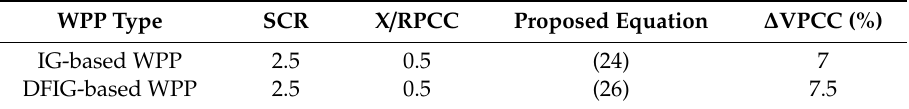
Table 11. ∆ V PCC obtained by (24) and (26) for X / R PCC = 0.5 and SCR =